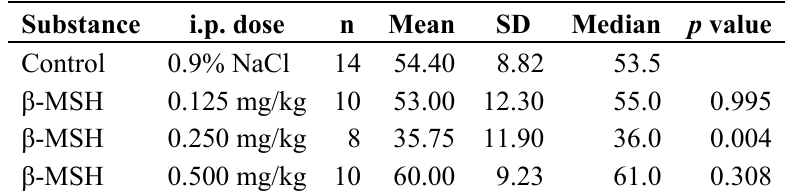
Table 2. Descriptive statistics (area of colonic necrosis as a percentage of total colon area) in experimental model of colitis. p value is a result of comparison with the control group (Steel’s test).